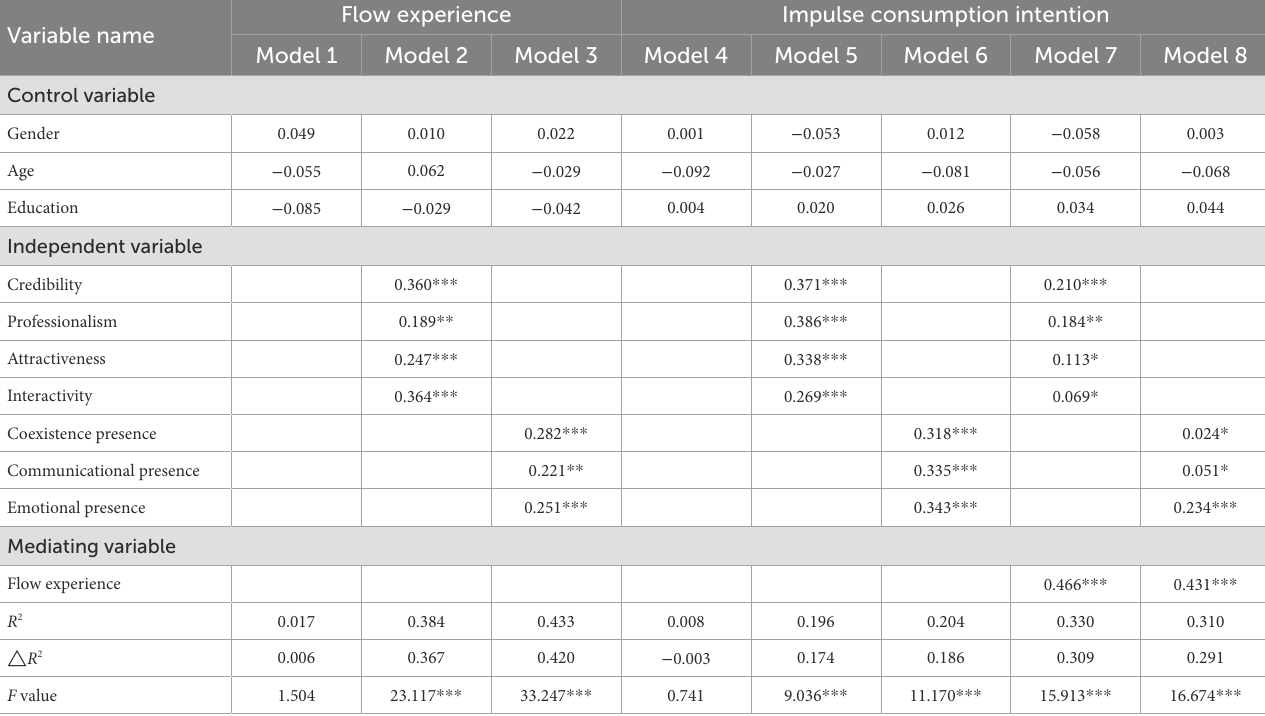
TABLE 5 Results of the main effect and mediating effect ( n = 268).